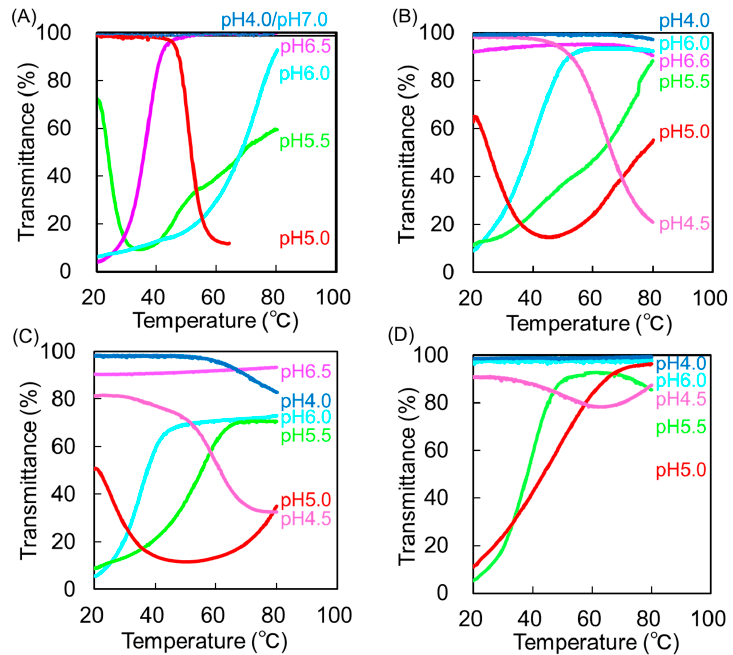
Figure 4. Temperature-dependent transmittance curves of aqueous solutions containing PAMAM- Phe-SO 3 Na with different Phe/PAMAM ratios at different pH values (1 mg/mL). ( A ) PAMAM- Phe57-SO 3 Na64, ( B ) PAMAM-Phe37-SO 3 Na68, ( C ) PAMAM-Phe27-SO 3 Na61, and ( D ) PAMAM- Phe16-SO 3 Table 3. pH-switchable thermosensitive behavior of PAMAM-Phe-SO 3 Na at different pH values 1 .